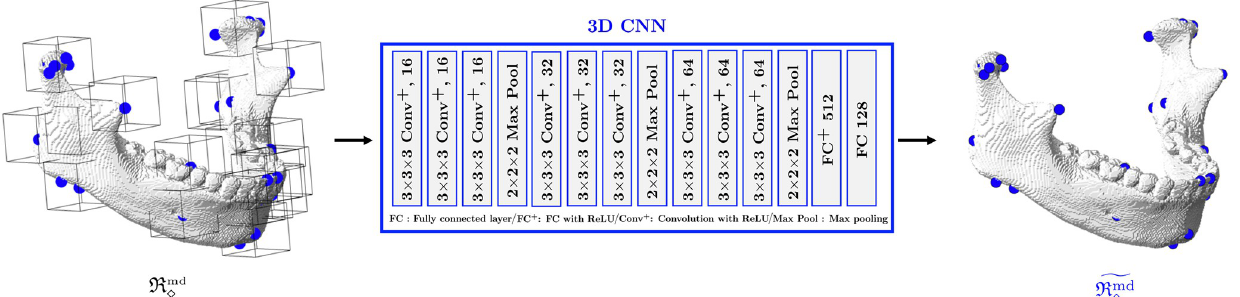
Fig 4. Mandibular landmarks detection. Patch-based 3D CNN is applied to the segmented image of the mandible (separated from the maxilla), in order to capture 3D morphological features of mandible associated with the landmarks. For six landmarks on condyle, we detect them all at once, instead of one by one, because they are positionally related to each